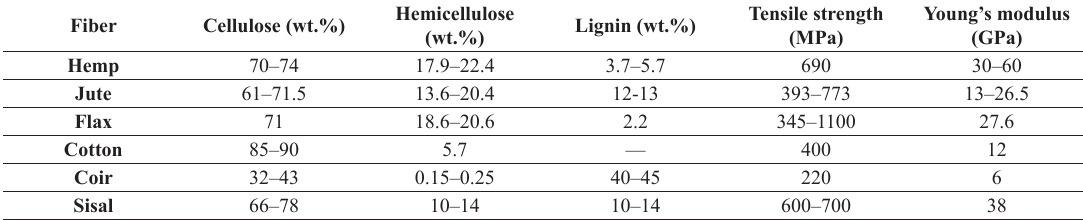
Table 1. The weight percentage of the major chemical composition and the tensile properties of some fibers. Fiber Cellulose (wt.%)